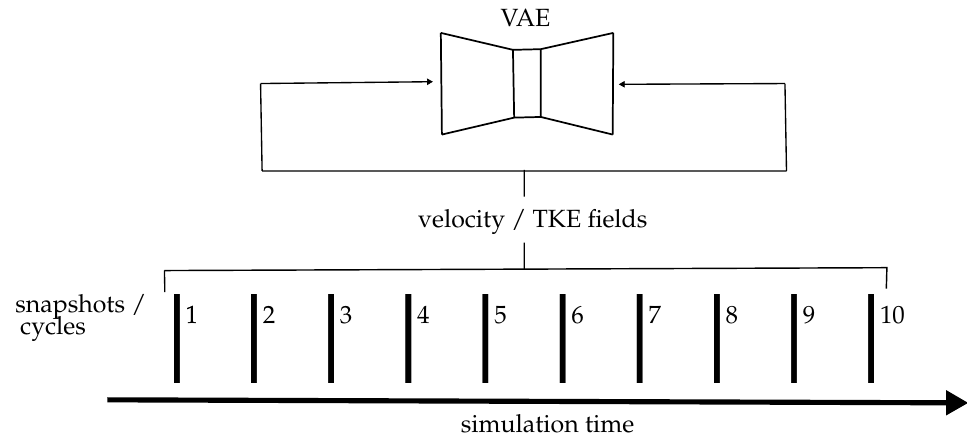
Figure 4. Training of the VAE with velocity and TKE fields in the specified domain of the ten cycles of the multicycle